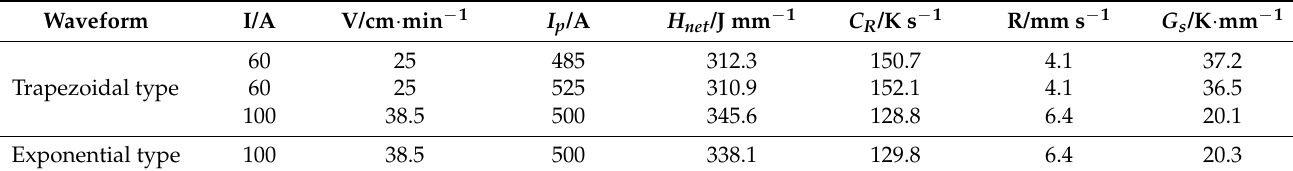
Figure 25. The volume proportion of PF phase and AF phase in weld microstructure. Table 2. The welding parameters used in this article.